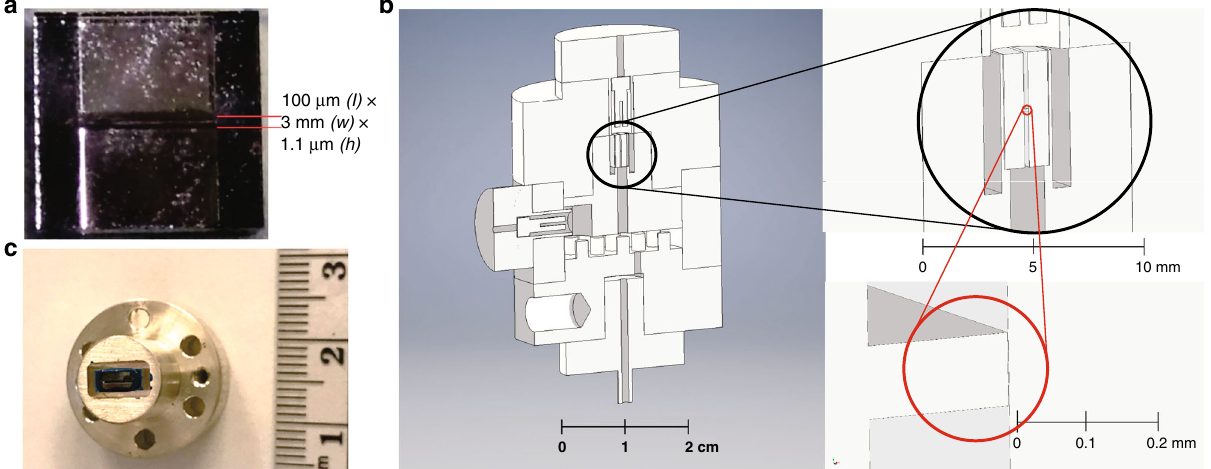
Fig. 1 Experimental details. a Image of the cavity containing the channel prior to mounting. b Schematic of the experimental cell with forks mounted in the isolated chamber (IC, depicted at the top) and in the heat exchanger chamber (HEC, located in the chamber below the channel) separated by the thermal conductance channel. The cavity in its mount is depicted schematically in the large black circle and the channel is depicted in the red circle. c Cavity mounted in coin-silver carrier, where the (blue) epoxy joint to the thin coin-silver wall is visible. Each small division is 1